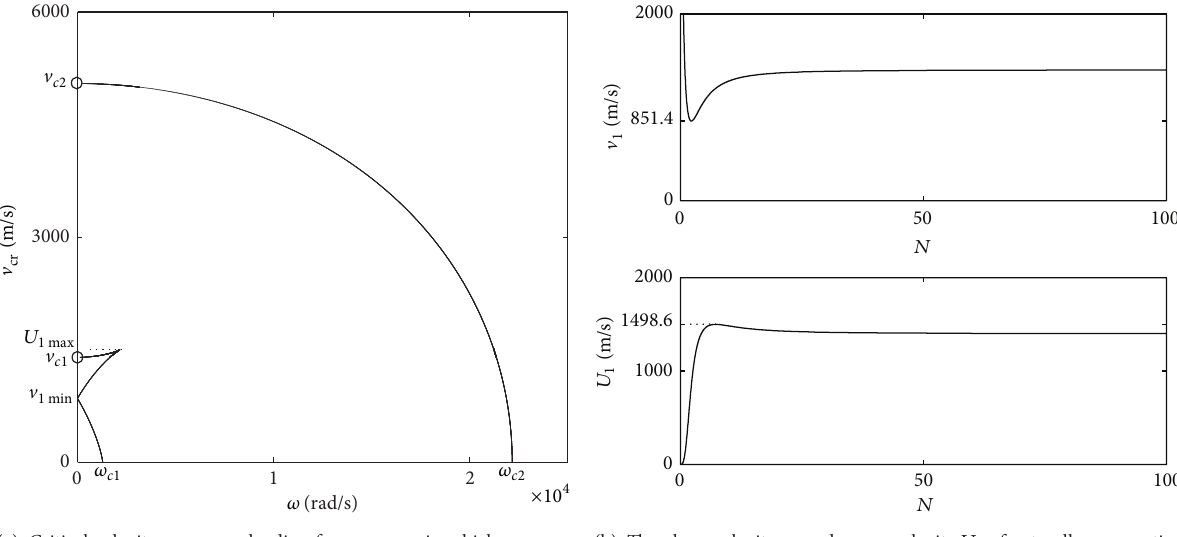
(a) Critical velocity V cr versus loading frequency 𝜔 , in which V 1 min = 851.4 m / s < V 𝑐1 , 𝑈 1 max = 1498.6 m / s > V 𝑐1 , as shown in Figure 4(b)